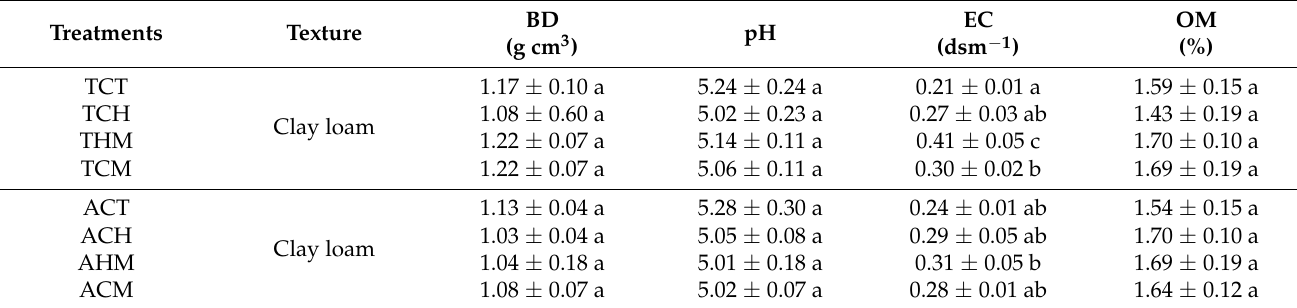
Table 2. Properties of the soils in field experiment from all treatments.